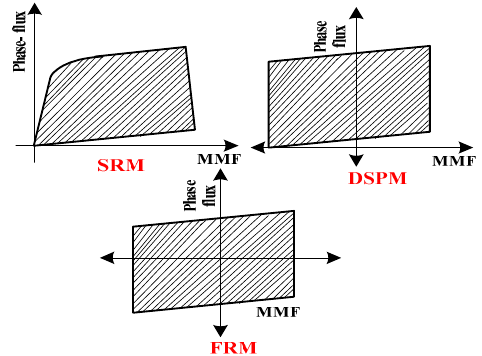
Figure 16. Comparisons with three double salient type machines [14].